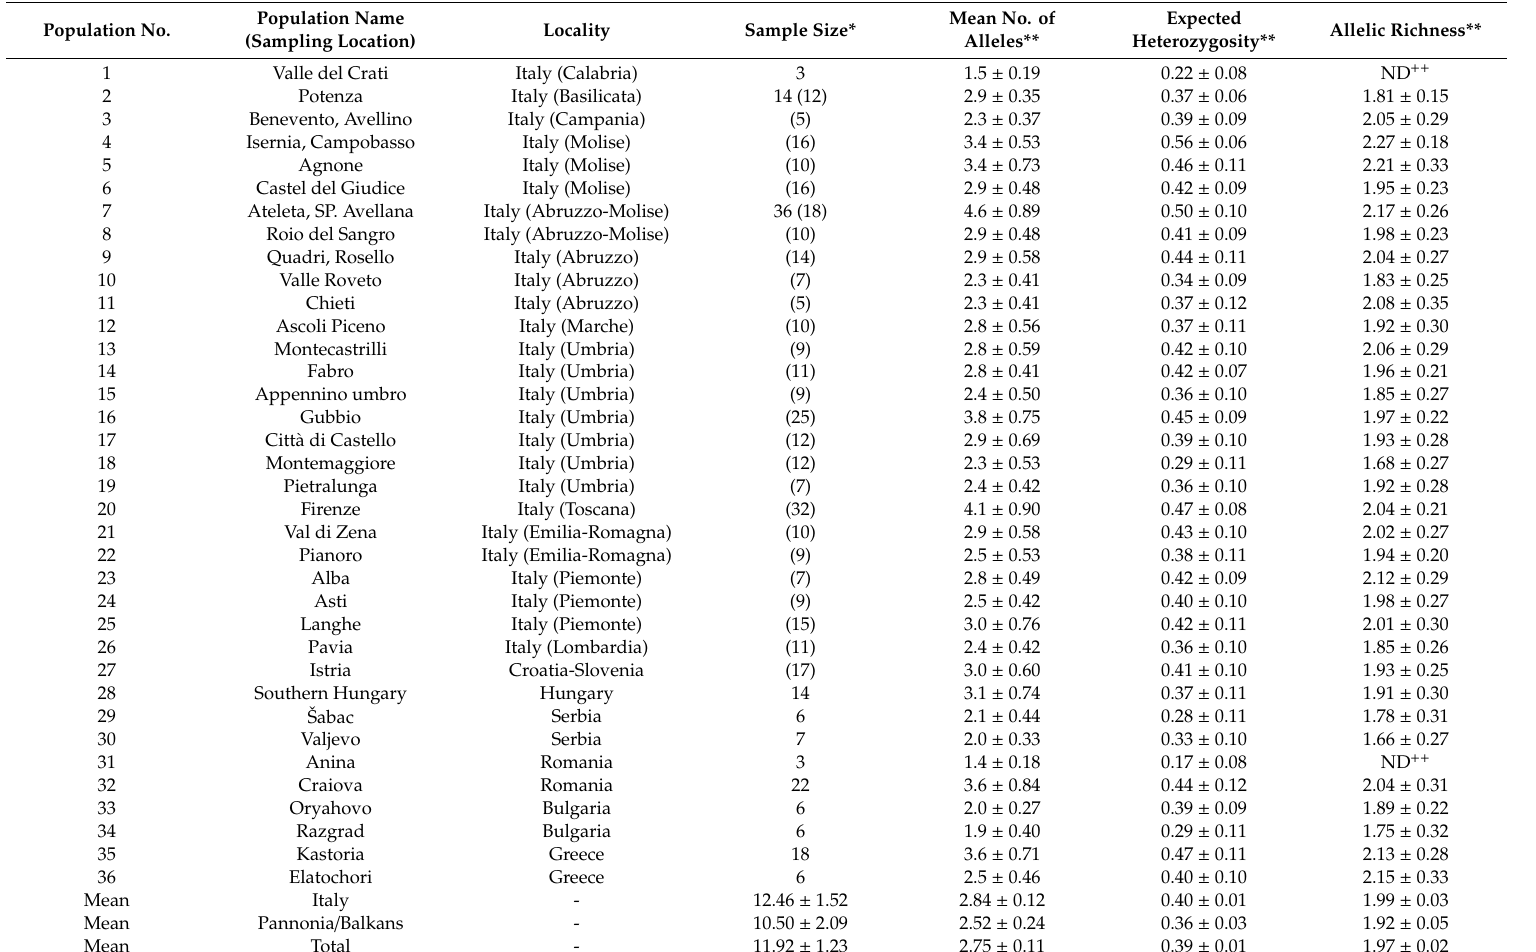
Table 1. Tuber magnatum samples considered in this